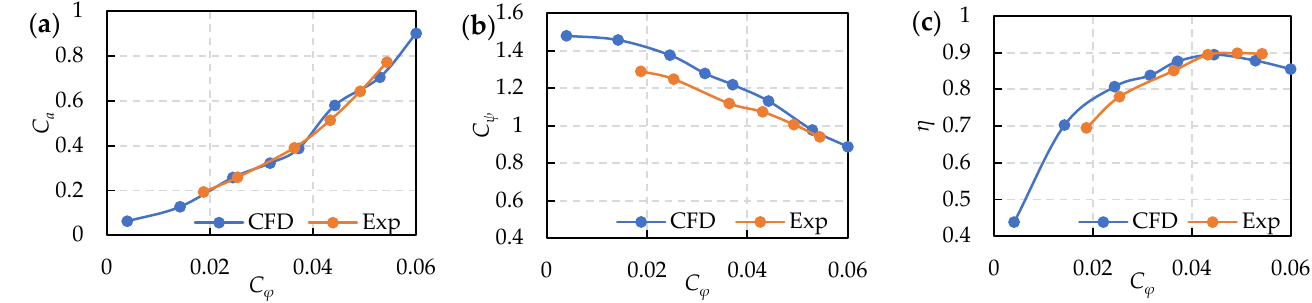
Figure 4. Guide vane opening C a ( a ) head coefficient C ψ ( b ) and efficiency η ( c ) vs. discharge coefficient C ϕ .